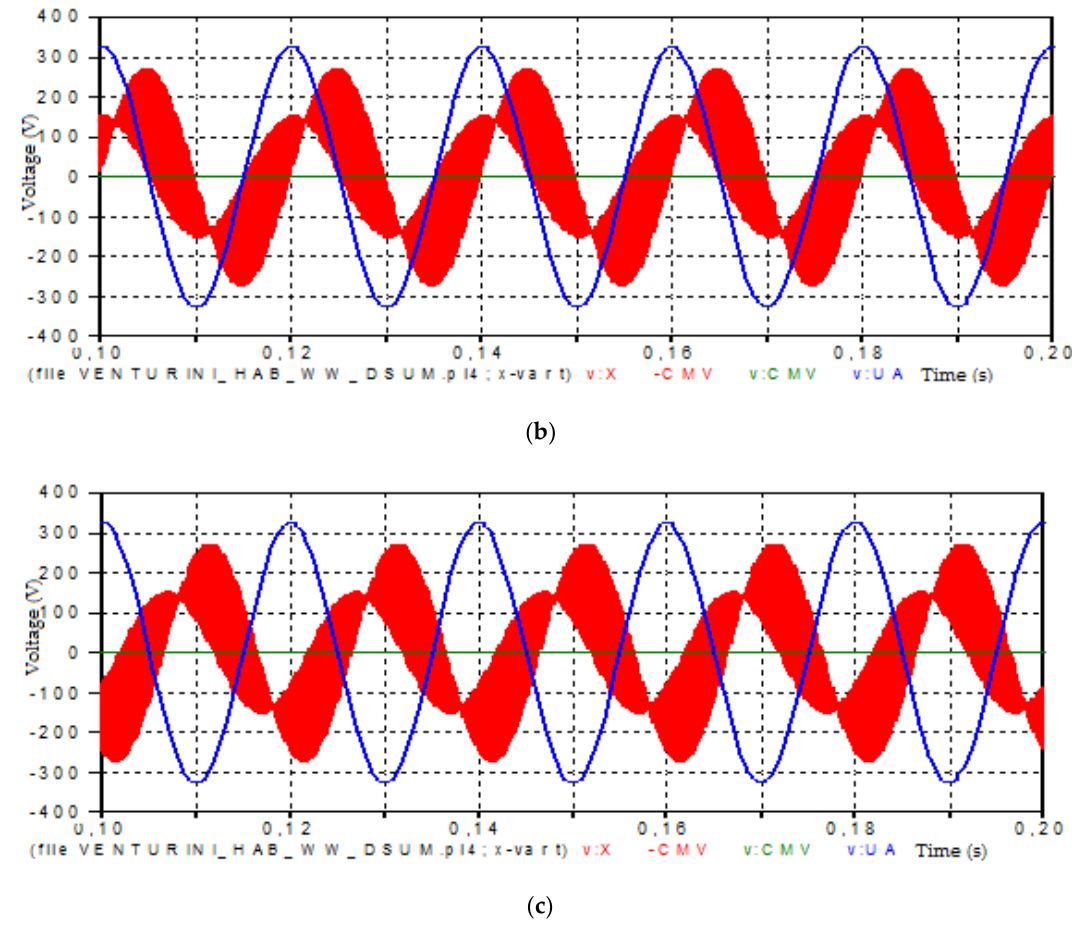
Figure 9. Waveform of the output voltages (red lines), input voltages (blue line) and CMV (green line) in MMC, controlled by the use of CCW rotating space vectors, for the output frequency of 50 Hz and angle ψ = 60° ( a ); angle ψ = ‐ 60° ( b ) and angle ψ = 180° ( c ).